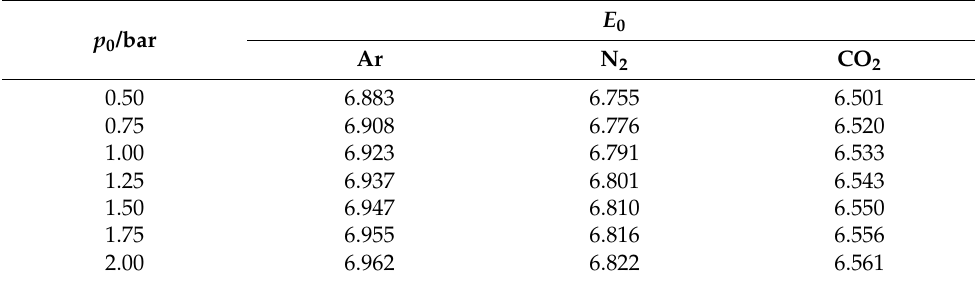
Figure 2. Expansion coefficients, E 0 , at p 0 = 1.5 bar and T 0 from 300 to 423 K for propane-air–10% diluent mixtures (Ar, N 2 or CO 2 ). Table 1. Expansion coefficients, E 0 , at T 0 = 333 K and various initial pressures for propane-air–10% diluent mixtures (Ar, N 2 or CO 2